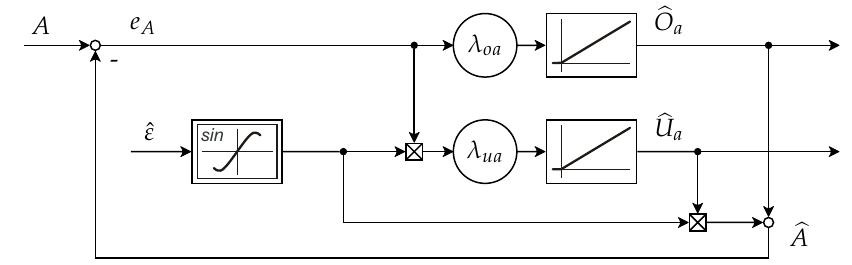
Figure 4. Scheme of the observer for the line signal A